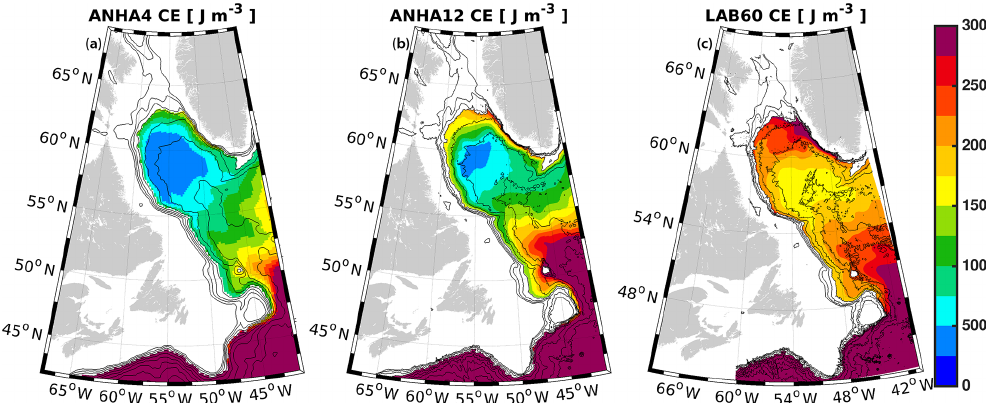
Figure 8. Convective energy (CE), the strength of stratification down to a reference depth of 2000m, is shown for (a) ANHA4, (b) ANHA12, and (c) LAB60. Convective energy was averaged from 2004 to 2013. Values where the depth of the seafloor was less than 2000m were removed to preserve clarity. Bathymetric contours (black lines) are shown every 500m.